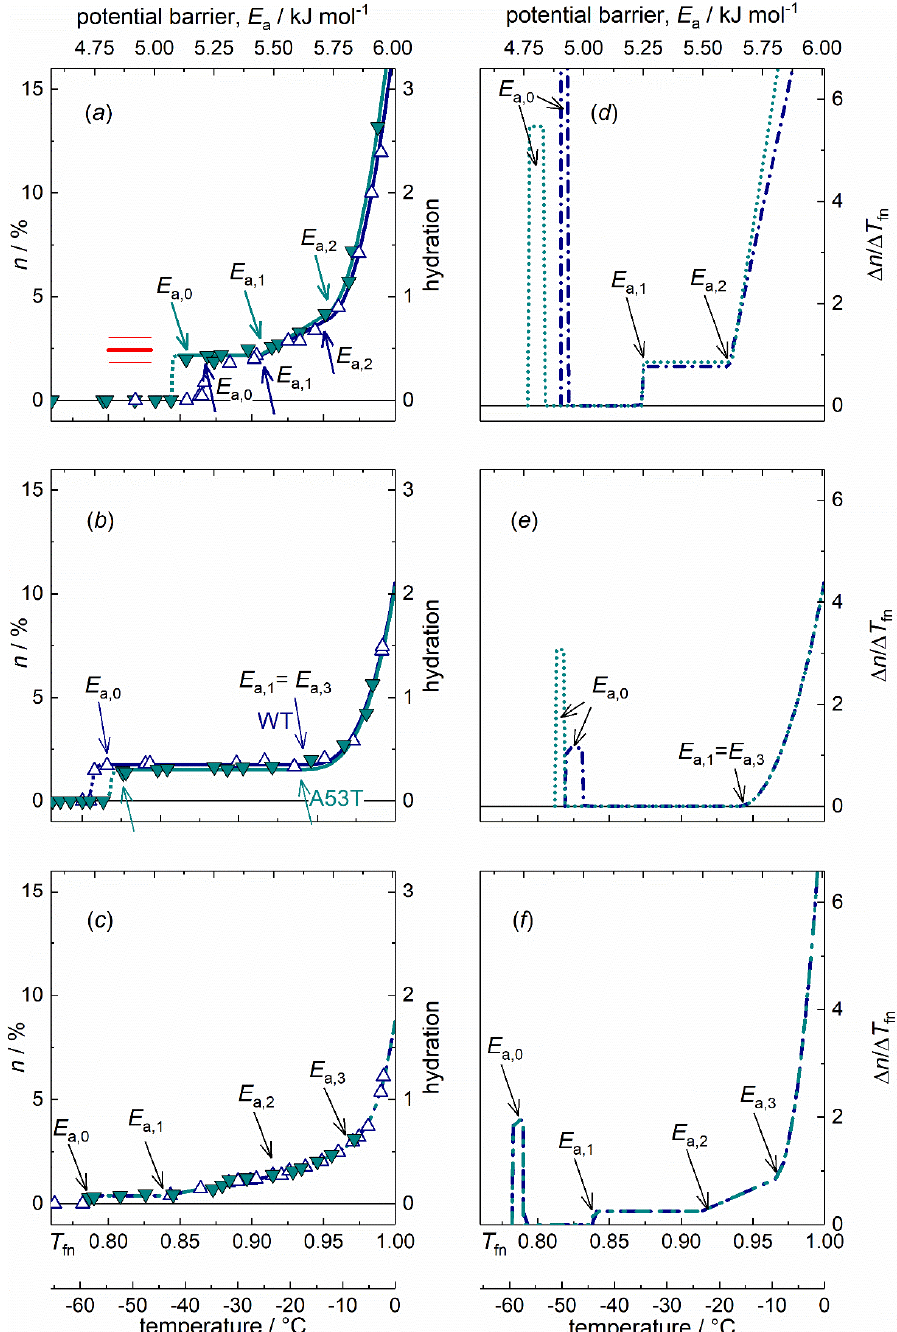
Figure 1. α -synuclein ( α S) monomers, oligomer and amyloids, wild type (dark blue open up triangles, dark blue dot-dashed lines) and A53T mutant (cyan solid down triangles, dotted cyan lines) variants dissolved in pure water: ( a ) α S monomers, ( b ) α S oligomers, ( c ) α S amyloids, melting diagrams; ( d ) α S monomers, ( e ) α S oligomers, ( f ) α S amyloids, derivatives of the melting diagrams, i.e., potential barrier distributions related to moving hydration water. There are no reliable measured data in the range − 1–0 ◦ C (0.995–1.00 T fn ). Data are given for 50 mg ml − 1 protein concentration. The red line on panel ( a ) is at the predicted hydration value h = 4(1) · 10 2